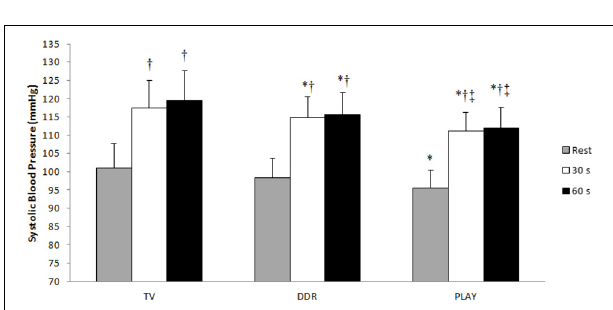
FIGURE 3 | Systolic blood pressure values during the Cold Pressor Test. TV, television; DDR, dance dance revolution; PLAY, traditional games; ∗ p ≤ 0 . 05 to TV in the same moment; † p ≤ 0 . 05 to rest in the same session; ‡ p ≤ 0 . 05 to DDR in the same moment.